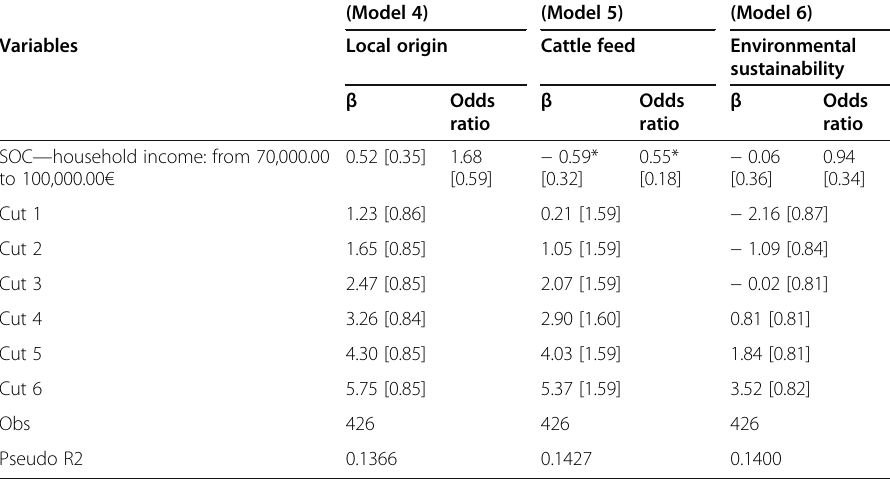
Table 4 Model estimation: beta coefficients and odds ratio for voluntary label disclosure